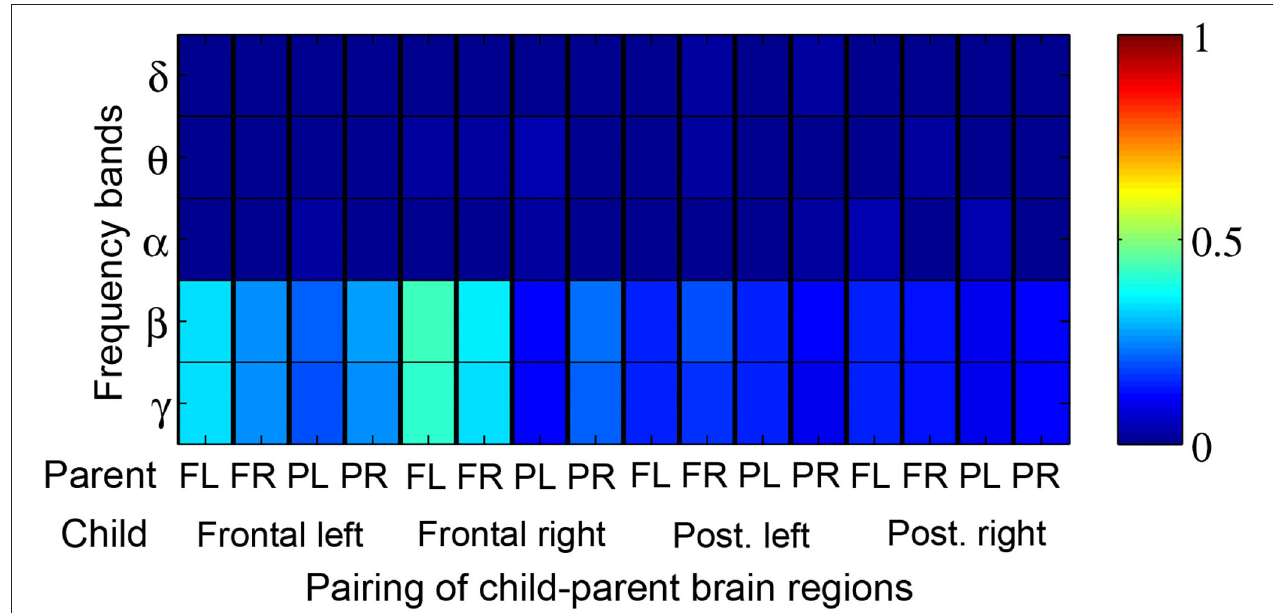
FIGURE 5 | Proportion of child-parent dyads exhibiting significant music therapy coherences with respect to their corresponding baseline segments. Red shading thus denotes 100% of dyads with significant coherence. The proportions are tabulated by frequency band (rows) and pairings of child-parent brain regions i.e., frontal left (FL), frontal right (FR), posterior left (PL), and posterior right (PR).